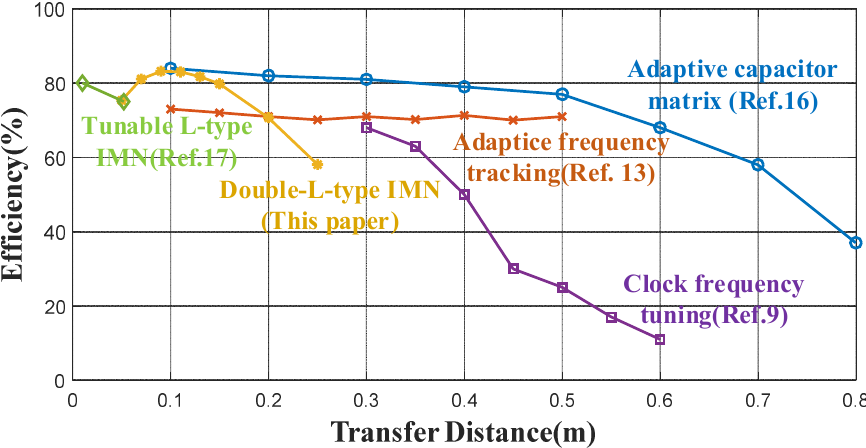
Figure 12. Efficiency for the system with double-L-type IMN and comparison with existing technologies (the data are from graph in the references).